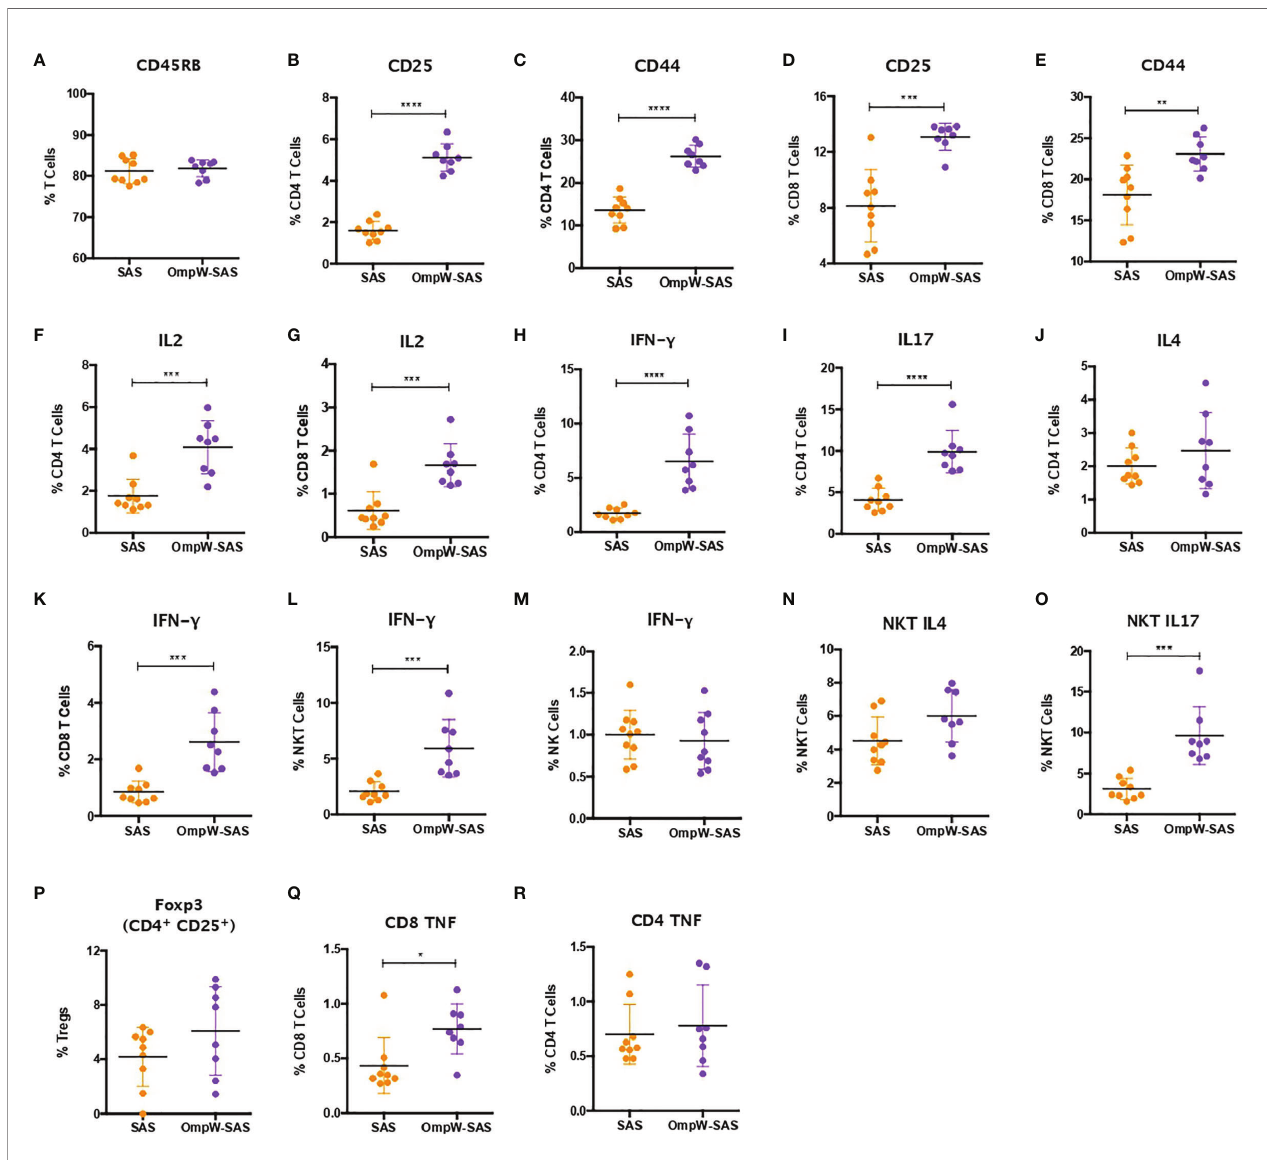
FIGURE 4 | Insulin-resistant mice mimicked with minimal changes the immune response to BpOmpW (homologue OmpW in Burkholderia pseudomallei ) produced by non-insulin-resistant mice. (A) Percentages of the CD45RB marker in total T cells. (B – E) Percentages of CD4 and CD8 T cells expressing CD25 and CD44 activation markers. (F, G) Percentages of CD4 (F) and CD8 (G) T cells expressing IL-2 cytokine. (H – J) Percentages of CD4 T cells expressing IFN- g (H) , IL-17 (I) , and IL-4 (J) . (K – M) Percentages of CD8 (K) , NKT (L) , and NK (M) cells expressing IFN- g . (N, O) Percentages of NKT cells expressing IL4 (N) and IL17 (O) . (P) Percentages of regulatory T cells (Tregs). (Q, R) Percentages of CD4 (Q) and CD8 (R) T cells expressing the tumor necrosis factor (TNF) cytokine. SAS , splenocytes from adjuvant-only mice exposed to BpOmpW ( orange circles , control) ( n = 11); OmpW-SAS , splenocytes from SAS-adjuvanted BpOmpW-immunized mice re-exposed to BpOmpW in vitro ( purple circles , treatment) ( n = 11). Asterisks denote statistically signi fi cant differences according to a two-tailed t -test. The levels of signi fi cance are represented as follows: * p < 0.05; ** p < 0.01; *** p < 0.001; **** p <